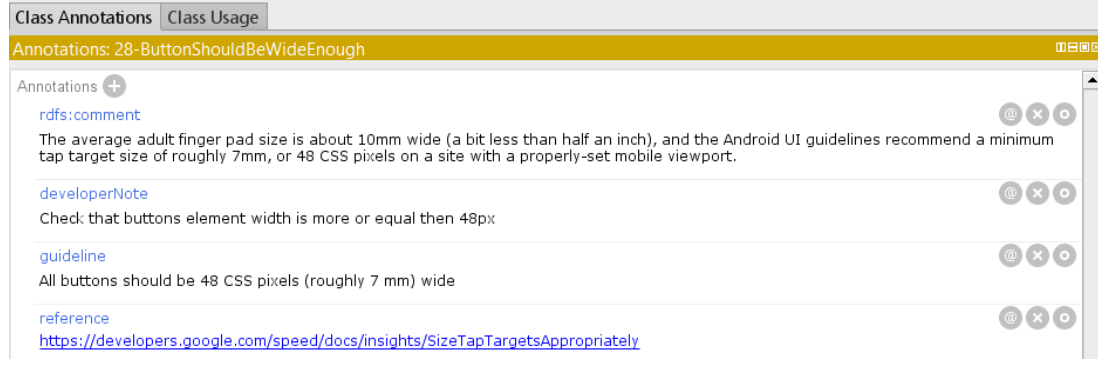
Figure 5. Example of guideline annotation with human-readable comments (screenshot from the Protégé ontology